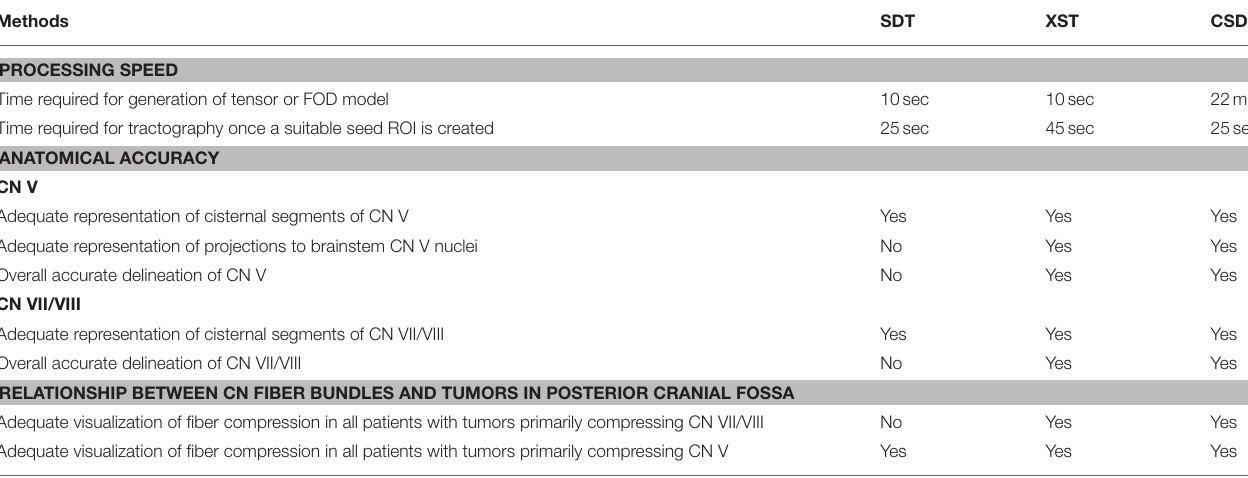
TABLE 4 | Summary of the results from the three tractography methodologies under consideration. Methods SDT CSD PROCESSING